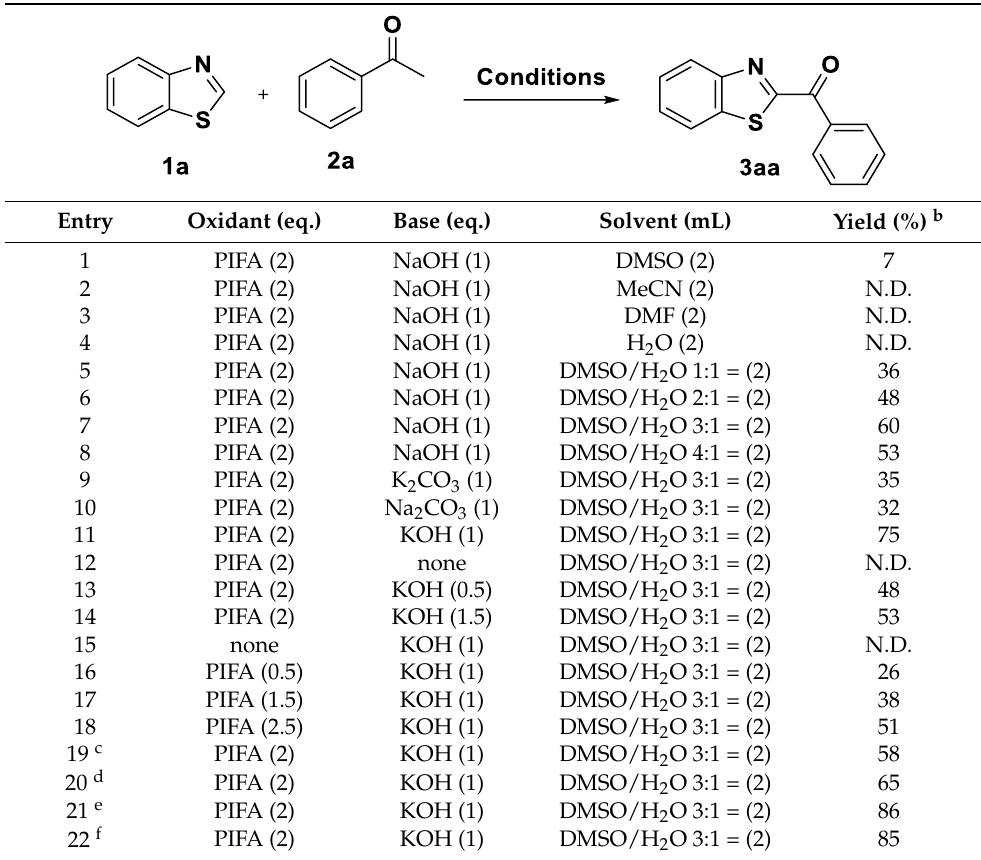
Table 1. Optimization of reaction conditions a .